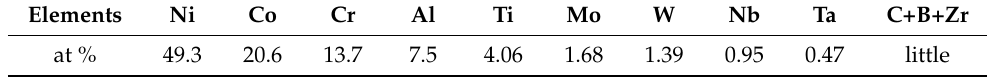
Table 1. Nominal composition of powder superalloy FGH100L (at.%).